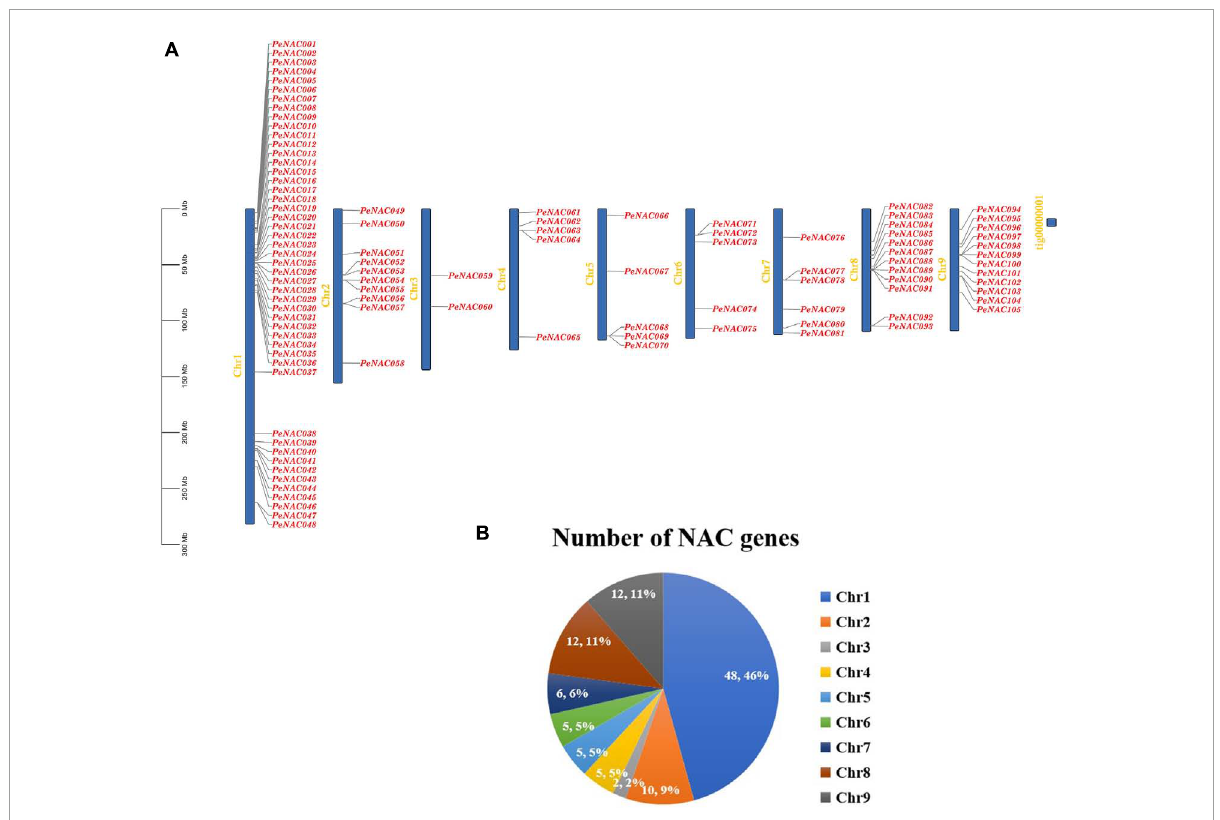
FIGURE4 Genomic location of PeNAC genes on passion fruit chromosomes. (A) Chromosomal location of PeNAC genes, the scale represents the 300MB chromosomal distance, and the PeNAC genes are represented in red color. (B) The sum number of PeNAC genes appeared on nine passion fruit chromosomes and the percentage (%) ratio of PeNAC genes from each chromosome is presented in pie charts; different colors indicate a different number of PeNAC genes and their ratio present in the chromosome of passion